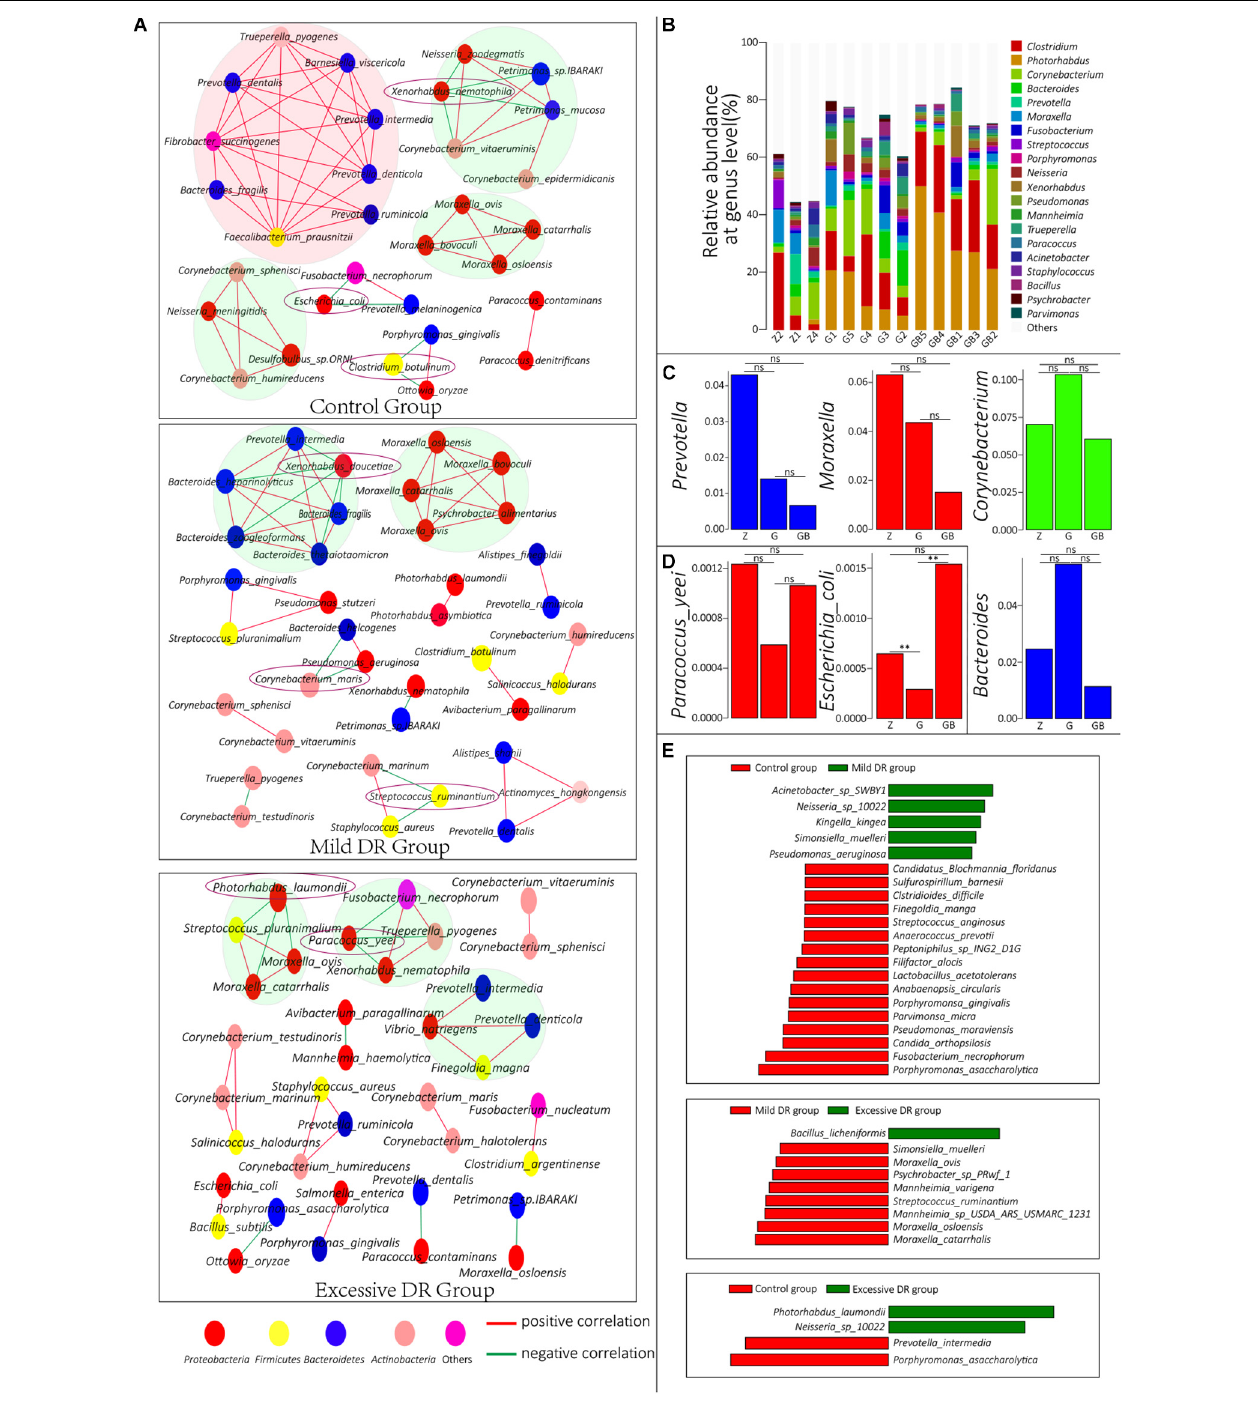
FIGURE 4 | (A) Co-correlation network of the top 50 species with the highest average relative abundance in each group. One circle indicates one species, and the species with the same color belong to a phylum with the corresponding color. (B) The top 20 dominant phyla with the highest average relative abundance in each sample and their percentages, Z for the control group, G for the mild DR group, GB for the excessive DR group. (C,D) The difference of average relative abundance of some key species and genus in each group, Z for the control group, G for the mild DR group, GB for the excessive DR group. ns: non-significant; *0 . 01 < p < 0 . 05; ** p < 0 . 01. (E) Linear discriminant analysis (LDA) effect size (LEfSe) analysis between groups. The red square indicates that the relative abundance increased, and the green square indicates that the relative abundance decreased. The length of the square indicates the magnitude of